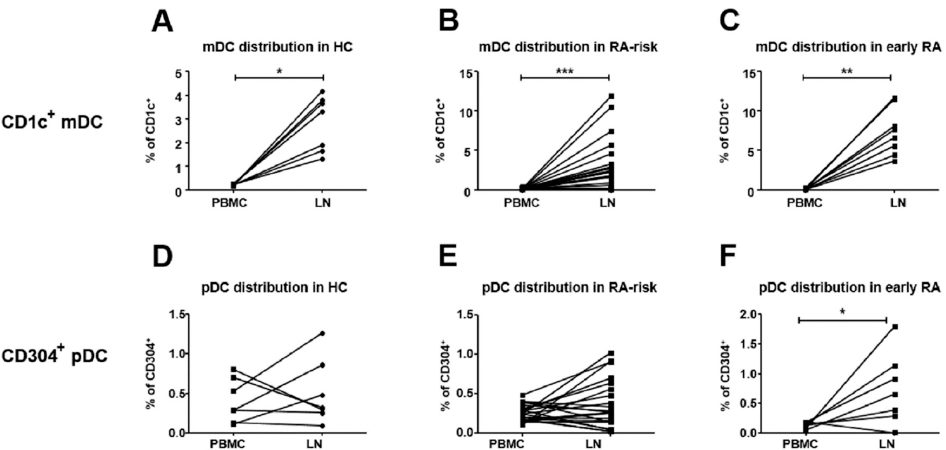
Figure 1. Myeloid (mDC and plasmacytoid(p)DC frequencies in lymphoid tissue and peripheral blood. Frequencies of mDCs ( A , B ) and pDCs ( C , D ) are determined in peripheral blood mononuclear cells (PBMC; A,C) and lymphoid tissue (LN; B,D). For PBMC, the frequencies are plotted as frequencies of the lineage (Lin) - HLA-DR + population. For lymph nodes (LNs) the frequencies are plotted as frequencies of the CD45 + HLA-DR + population. PBMC: HC ( n = 7), RA-risk ( n = 21) and RA ( n = 8). LN: HC ( n = 8), RA-risk ( n = 22), RA ( n = 15 or 18). Data are presented as median with interquartile range (IQR). For statistical analysis, a Kruskall–Wallis test was performed and significant differences were determined using a post Dunn’s multiple comparisons test and indicated as * p < 0.05 or ** p < 0.01.